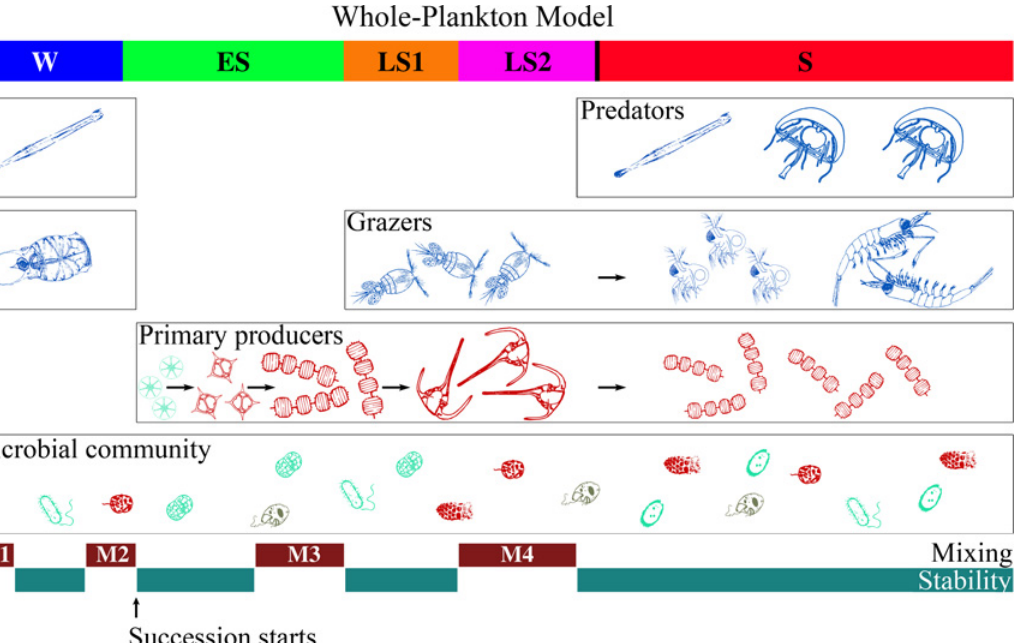
Fig 6. Conceptual representation of the whole-plankton model. The top coloured bar represents the periods identified from the clustering analysis based on biological variables ( i . e . PEC time series; coloured bar as in Fig. 3). Each trophic community is represented in a horizontal box, and the boxes are stacking up from bottom to top. In the primary producers and grazers boxes, the black arrows represent the traditional replacement-based ecological succession. The stacking of trophic boxes represents the stacking of trophic level occurring over the course of the succession. Each group of organisms depicted here is defined in Fig. 2. The bottom bars identify the periods of vertical mixing and stability of the water